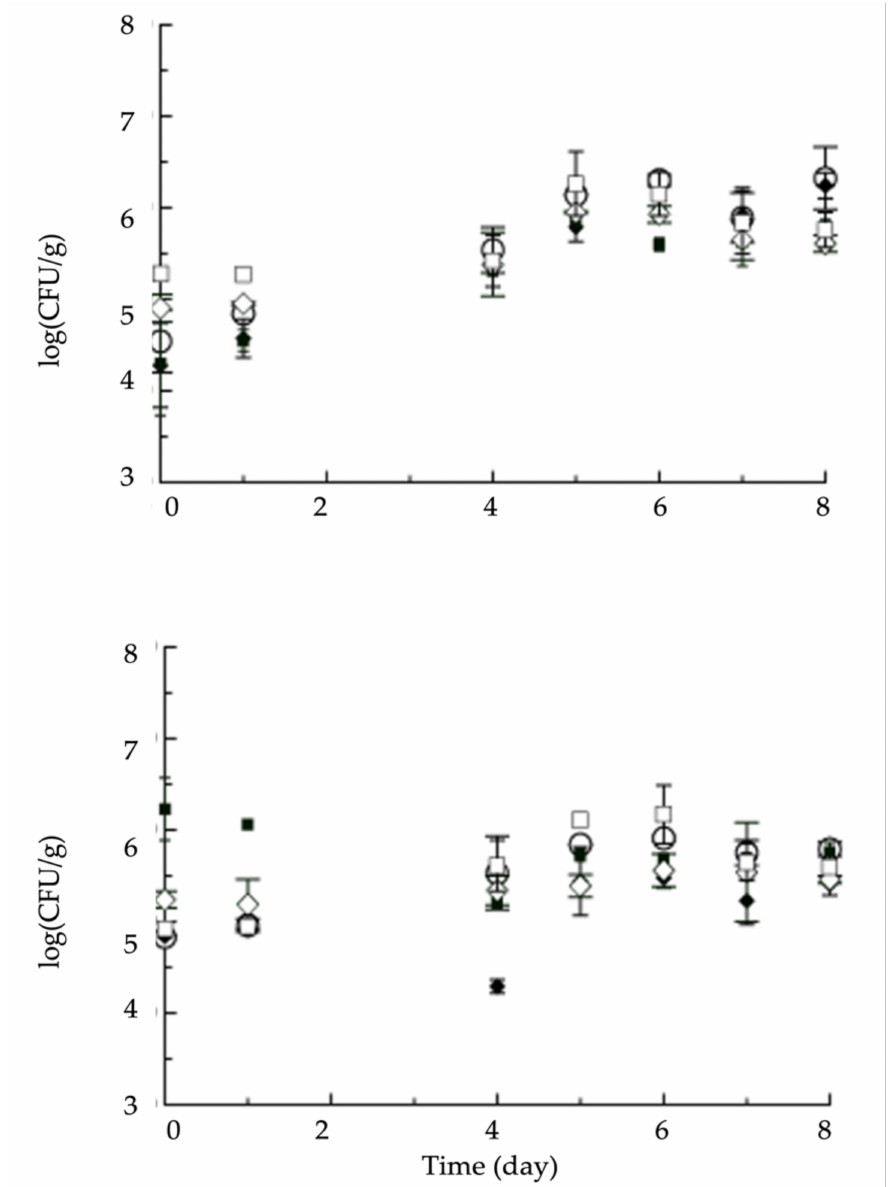
Figure 3. Evolution of lactic acid bacteria in Giuncata cheese during the storage period (8 days). Experimental data are presented as means ± standard deviation. Control